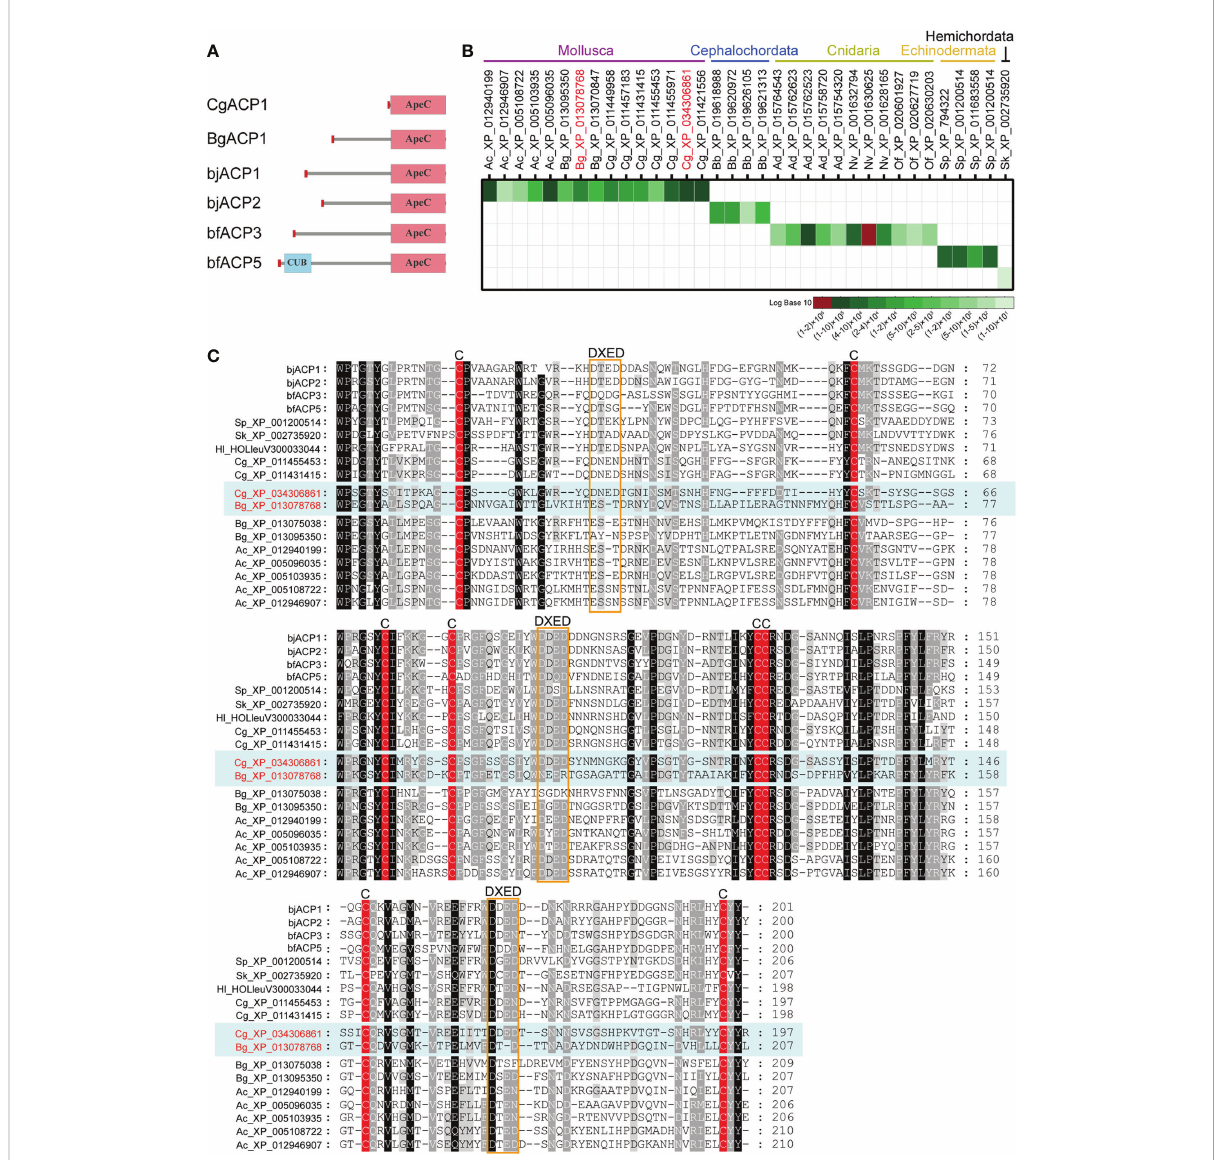
FIGURE 2 Comparison of the amino acid sequences and the global expression levels of a set of representative ACPs. (A) The domain architectures of the oyster CgACP1 and the snail BgACP1 compared with the amphioxus ACP1/2/3/5. (B) The accumulated expression level of a set of representative ACPs based on the RNA-seq data from NCBI ’ s gene browser. The accession for CgACP1 and BgACP1 are highlighted in red. The raw expression data are shown in Supplementary Table 2. (C) A multiple alignment of the ApeC domains of several short-form ACPs selected from different aquatic invertebrates. The conserved cysteine residues and the DXED motifs are highlight by red color and orange boxes, respectively. The accession of CgACP1 and BgACP1 are also highlighted in red. Ac, Aplysia_californica ; Bg, Biomphalaria glabrata ; Cg, Crossostrea gigas ;